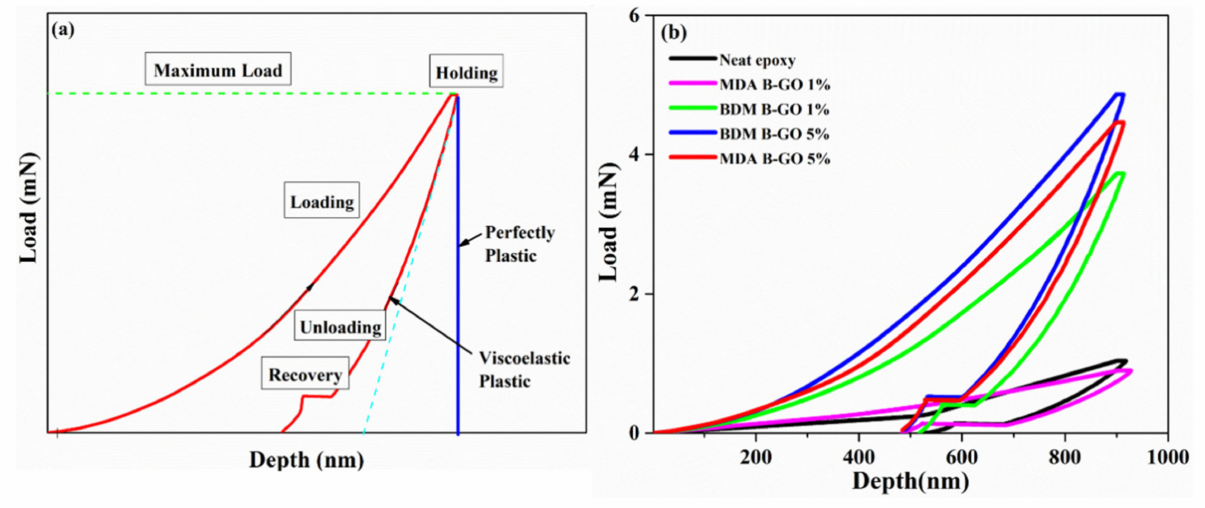
Figure 11. ( a ) Representative nanoindentation curve ( b ) Indentation curves for neat epoxy and its nanocomposites. Table 6. Mechanical properties of neat epoxy and its nanocomposites.